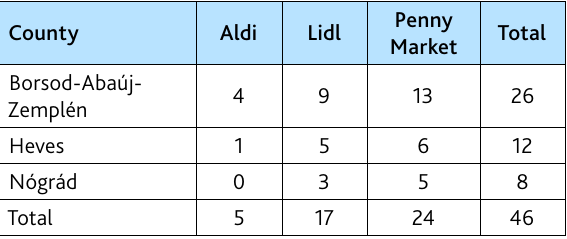
Table 2. Distribution of discounter stores by county, 2022 County